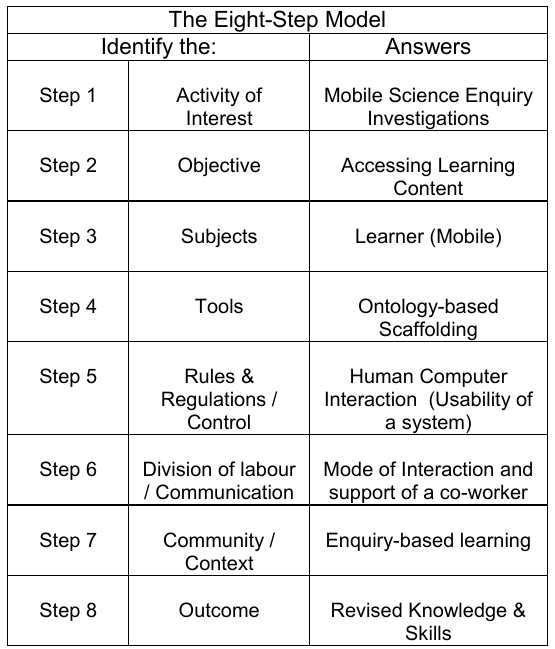
Table 1 Eight-Step Model, adopted from [22].